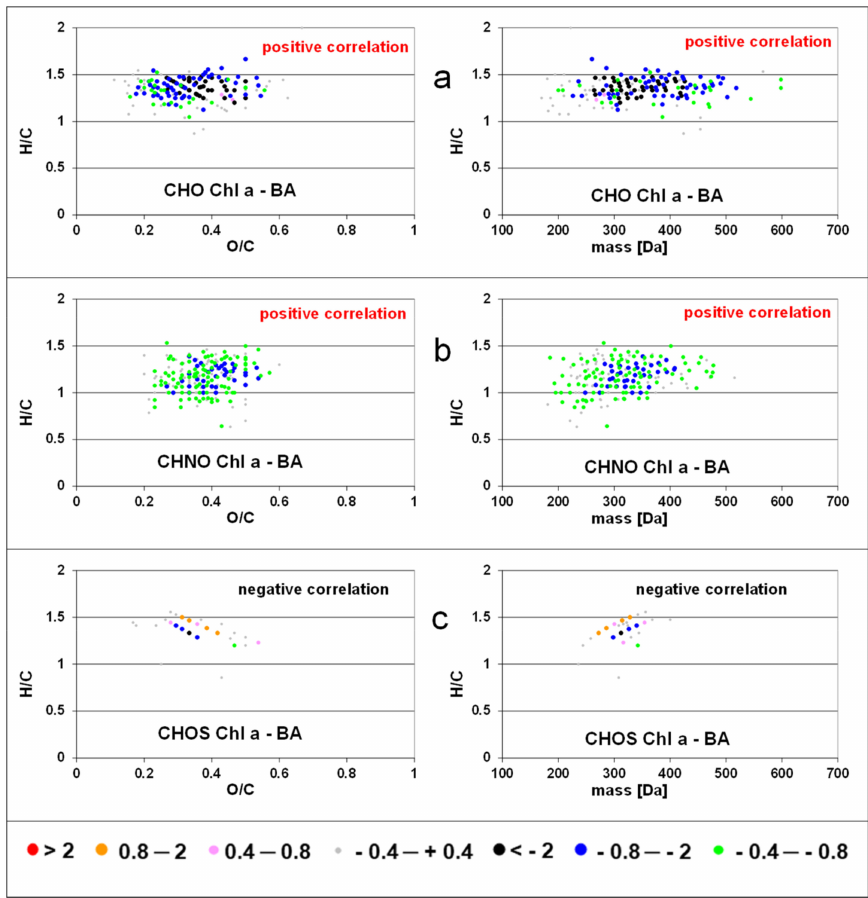
Figure 4. Di ff erences of slopes between solid phase extractable dissolved organic matter (SPE-DOM) molecularformulasversuschlorophyllaconcentration(Figure2)minusthoseversusbacterialabundance (Figure 3) for CHO ( a ); CHNO ( b ); and CHOS components ( c